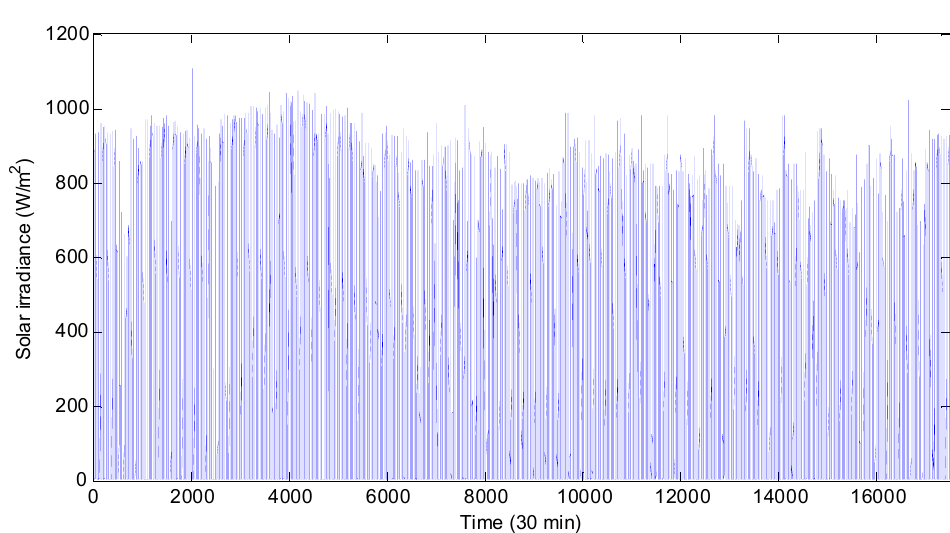
Figure 5. Solar irradiance over the year (W / m 2 Figure 5. solar irradiance over the year (W/m 2 ). Figure 5. solar irradiance over the year (W/m 2 ).